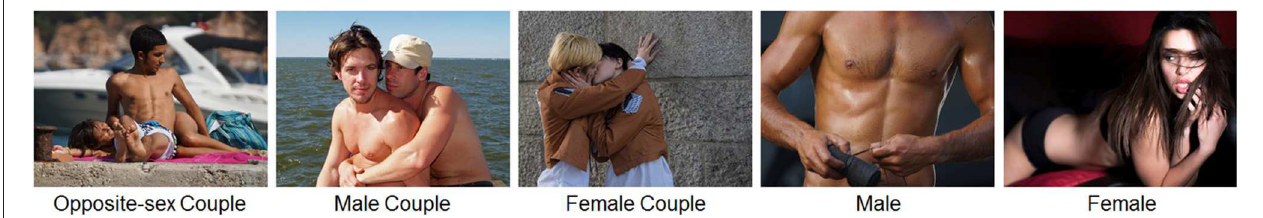
FIGURE 1 | A sample image from each category. All images were obtained from Flickr and were published under a Creative Commons license. Credits (from left to right): Charles Roffey, CC BY-NC-SA 2.0; David Shankbone, CC BY 2.0; Georgie Pauwels, CC BY 2.0; Charles Roffey, CC BY-NC-SA 2.0; Lies Thru a Lens, CC BY 2.0. For license terms see: CC BY 2.0 (https://creativecommons.org/licenses/by/2.0/); CC BY-NC-SA 2.0 (https://creativecommons.org/ licenses/by-nc-sa/2.0/).